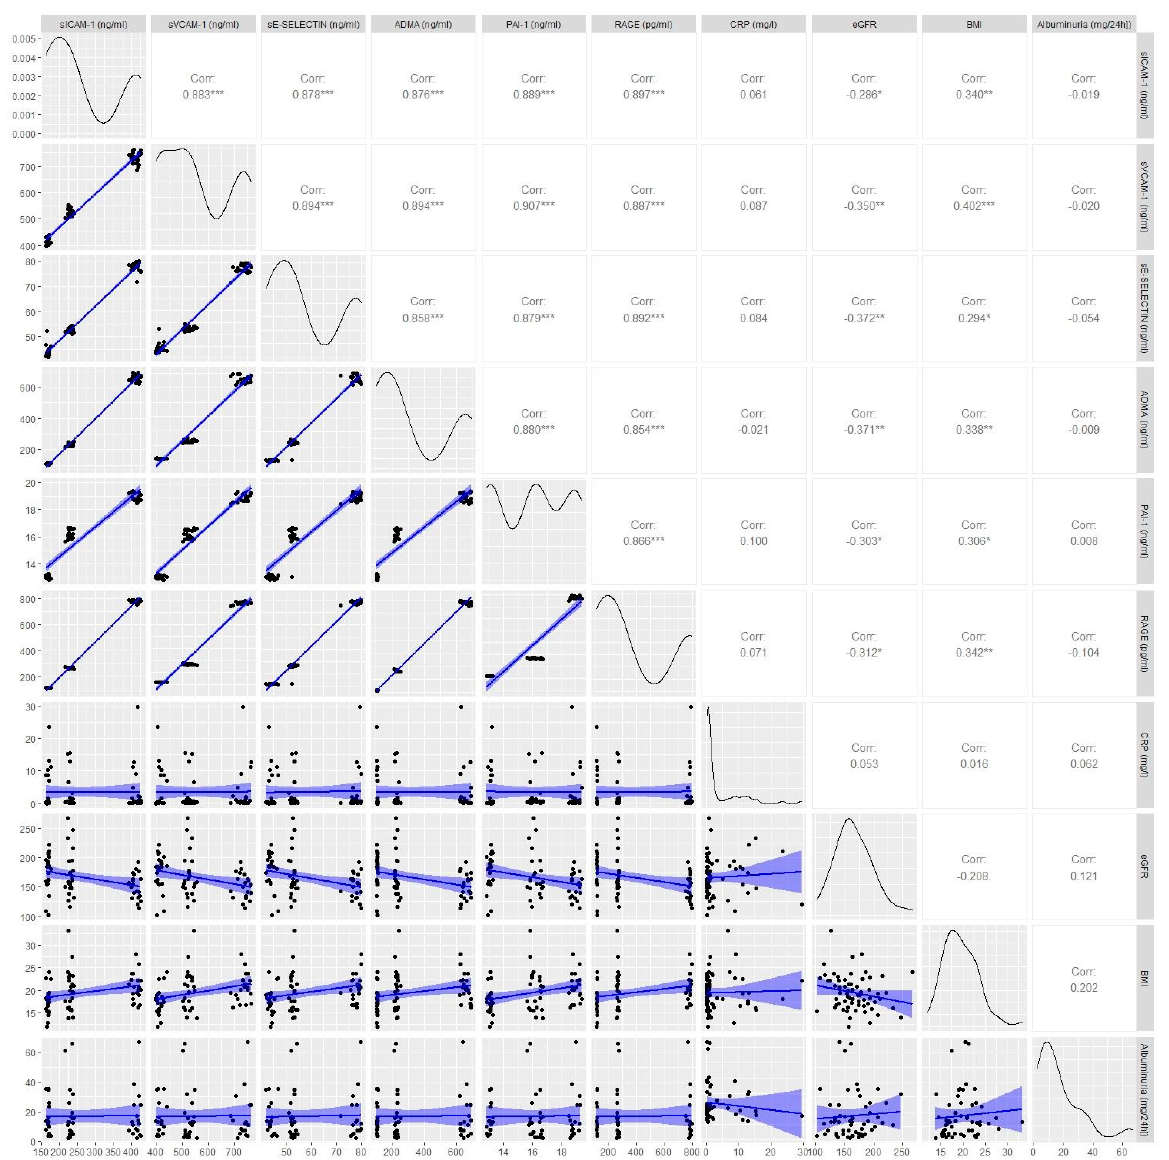
Figure 5. The indices of correlation among selected diagnostic features. Correlogram shows scatterplots for each pair variables in the bottom left part, and Spearman’s correlation coefficient is shown in the upper right part. Distribution of variables is shown diagonally. Legend: *— p -value < 0.05; **— p -value < 0.01, ***— p -value < 0.001.